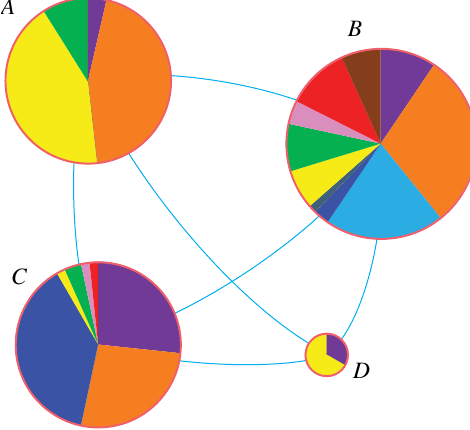
FIG. 9. Communities of the Nikkei 225 (log-returns of daily closing prices from 2001Q4 to 2011Q3) generated using our correlation-based modularity Q 3 ð ~ σ Þ with the Louvain algorithm (see the Appendix). Individual communities are labeled A through D , and the pie chart represents the relative composition of each community based on the industry sectors of the constituent stocks (color legend in Table I). The blue intercommunity link weights are negative, indicating that the communities are all residually anti- correlated. The red circles around each community indicate that the total intracommunity correlations are all positive.